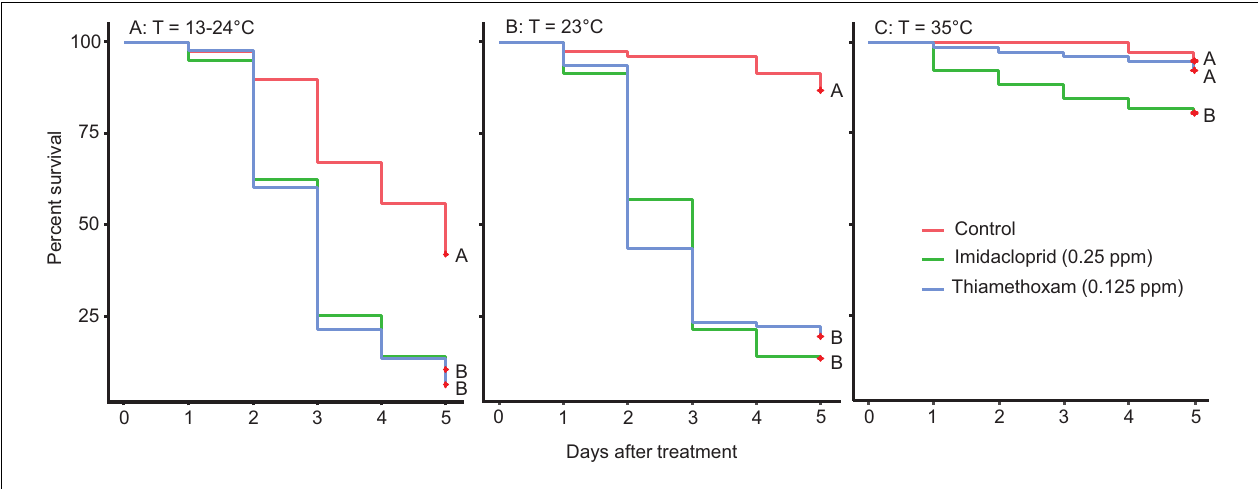
FIGURE 2 | Results of Trial 3 showing Kaplan–Meier survival curves of bees fed with imidacloprid or thiamethoxam or sugar only (control) at 13–24 ◦ C ( left , A ), 23 ◦ C ( middle , B ), or 35 ◦ C ( right , C ). Different letters at each line indicate significant differences with Log Rank tests at P < 0.05.